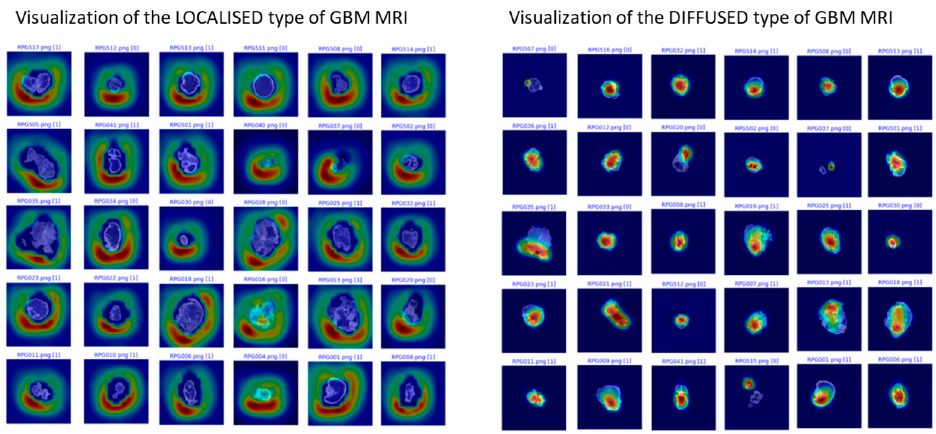
Figure 2. Visualization of the neural network classification result.